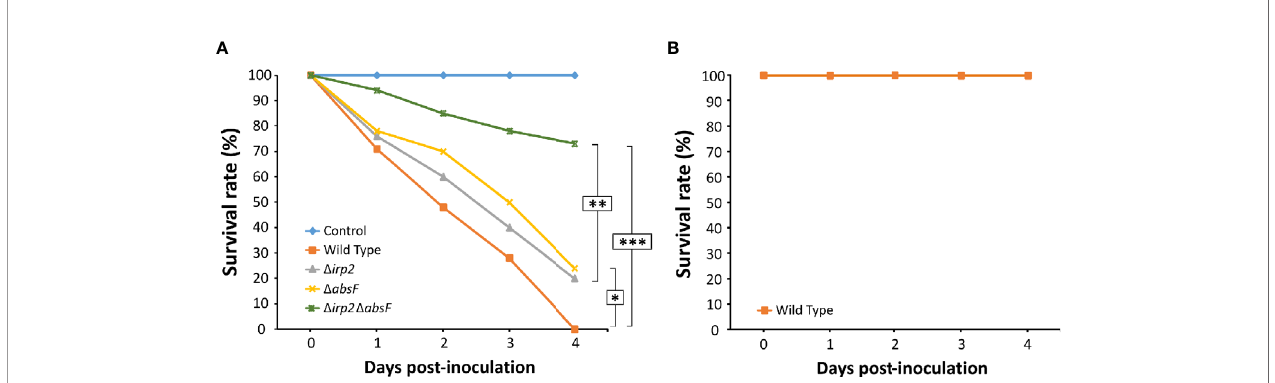
FIGURE 6 | Survival curves after infection challenge in clams ( Ruditapes philippinarum ) (A) and turbot (B) with V. neptunius wild-type strain and its derivatives D absF , D irp2 and D irp2 D absF mutants. Asterisks denote statistically signi fi cant differences between strains (* P < 0.05; ** P < 0.01 and *** P